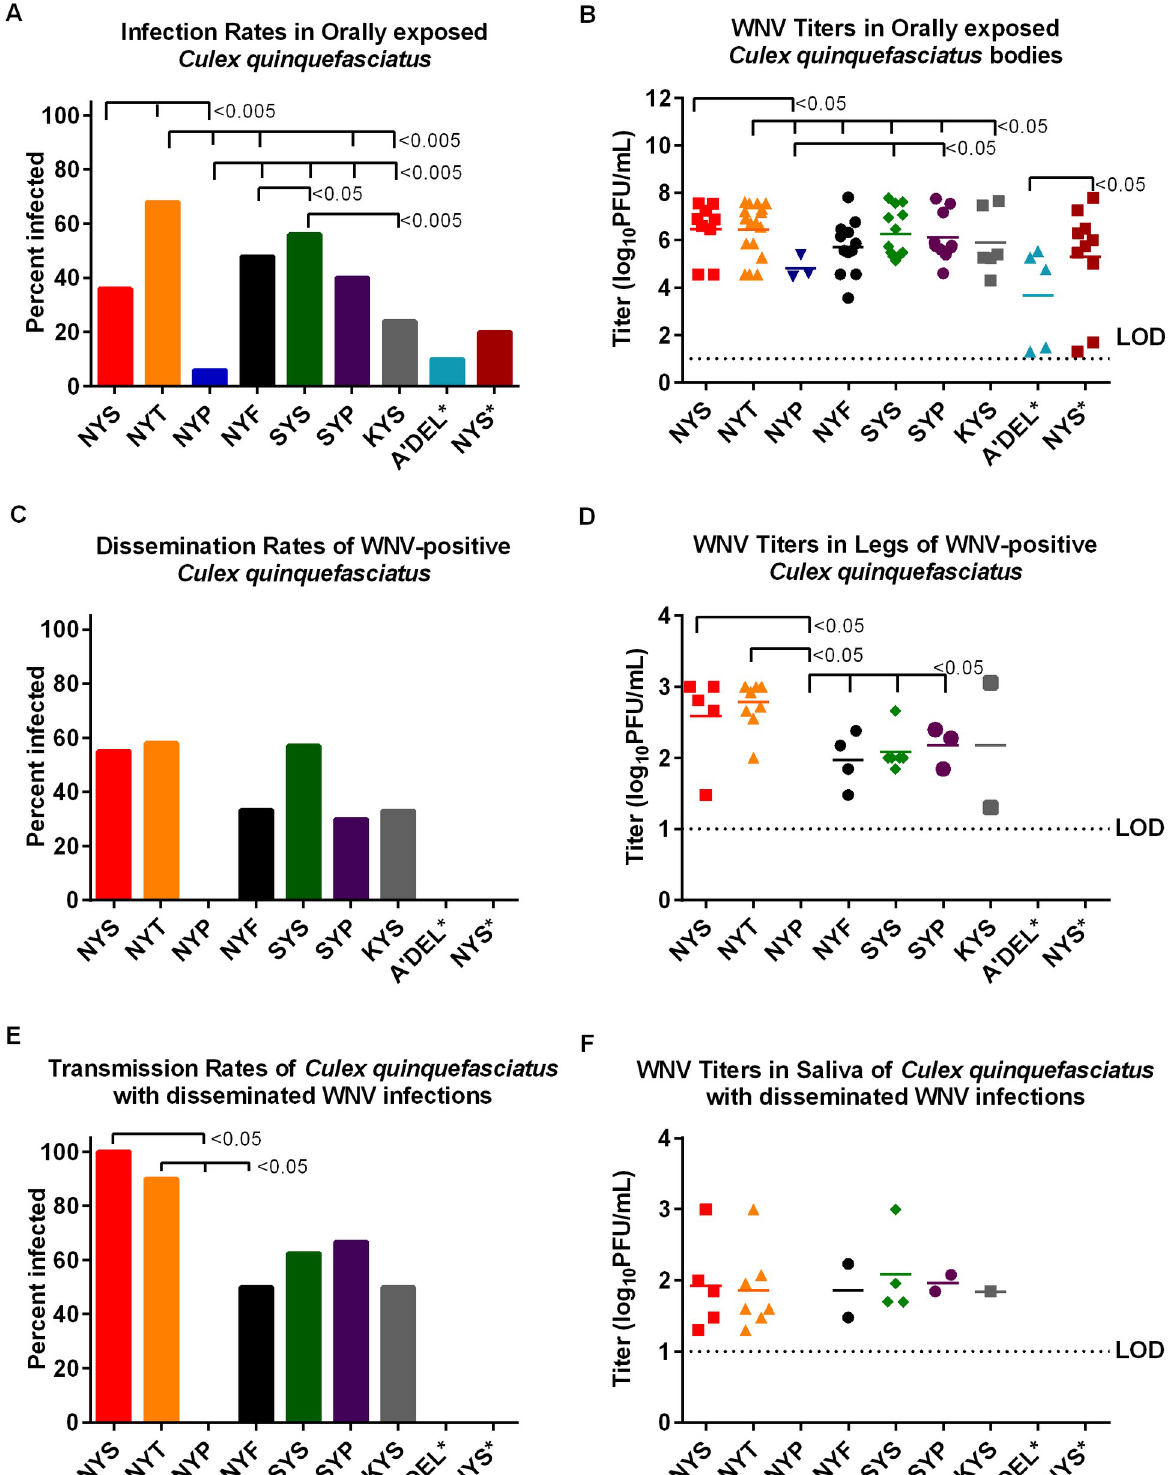
Fig 5. Vector competence assessment of WNV glycosylation mutant viruses in Culex quinquefasciatus . Culex quinquefasciatus were orally exposed to individual artificial blood meals containing 7 log 10 PFU/mL of the WNV parental (NYS) or glycosylation mutant viruses (NYT,